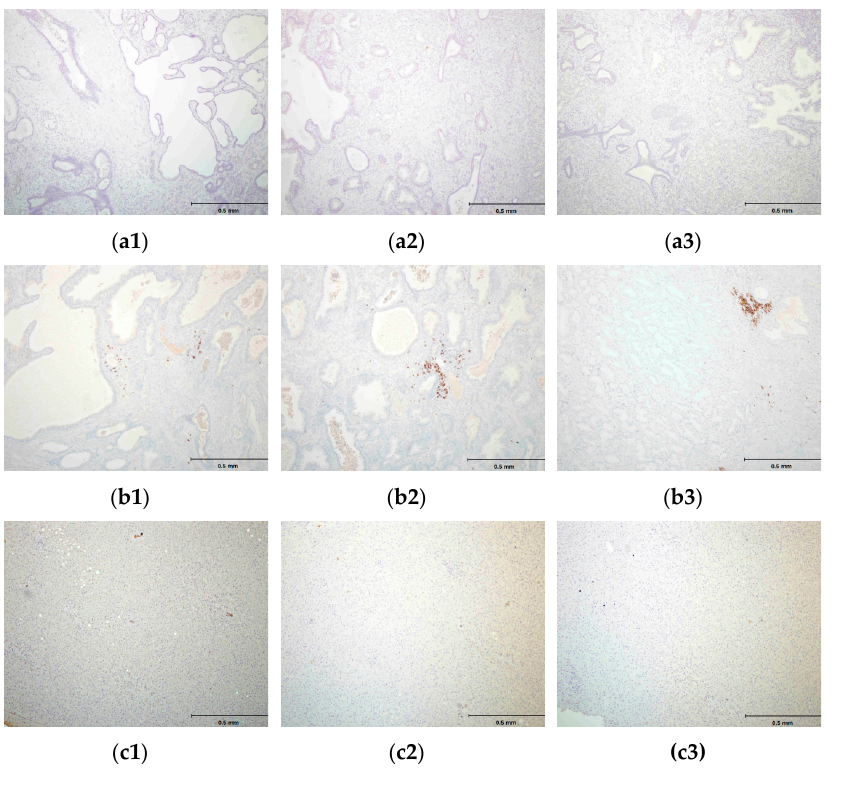
Figure 7. ( a1 , a2 , a3 ) Negative control peptide: Immunohistochemistry (IHC) staining of the prostate tissue with a peptide Biotin-EHFRW that does not bind to hPSA epitope RHSLFHP. ( b1 , b2 , b3 ) Negative control antibody ― prostate tissue: IHC staining with CD20 (L26) monoclonal antibody; only inflammatory cells are stained. (c1 , c2 , c3) Negative control tissue ― liver tissue: IHC staining with the antisense paratope Biotin-AVRDKVG that binds to hPSA epitope RHSLFHP. Scale bar = 0.5 mm. Table 4. Quality control of hPSA staining with antisense peptide dilutions, based on NordiQC scoring criteria: 0—Poor; 1—Borderline; 2—Good; 3—Optimal [57]. Patient No. \ Dilutions*